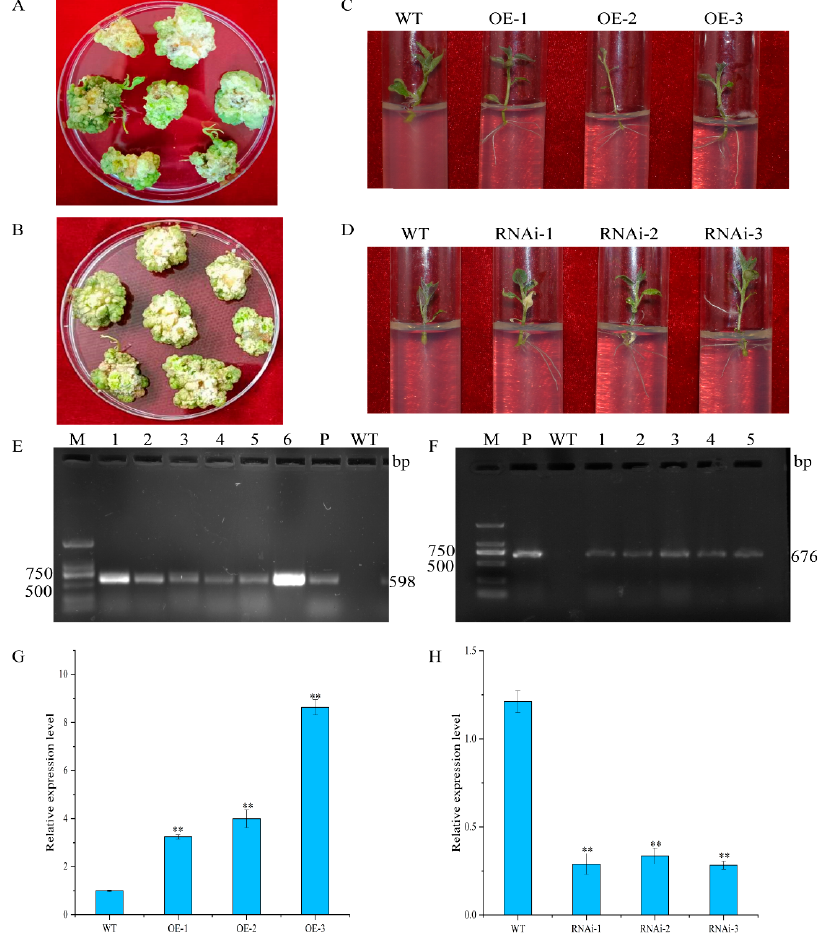
Figure 4. Acquisition and identification of transgenic plants. ( A , B ) Callus and differentiated buds. ( C , D ) Rooting and screening transgenic plants. WT: Wild-type plant “Atlantic”; OE: Transgenic